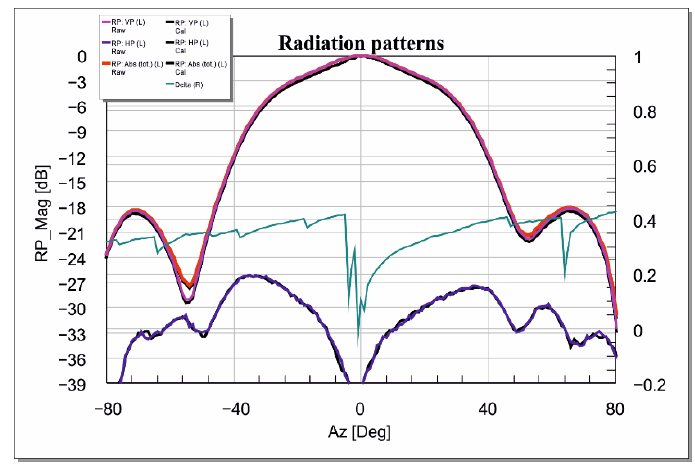
Figure 10. AUT radiation patterns at frequency f = 3.75 GHz.